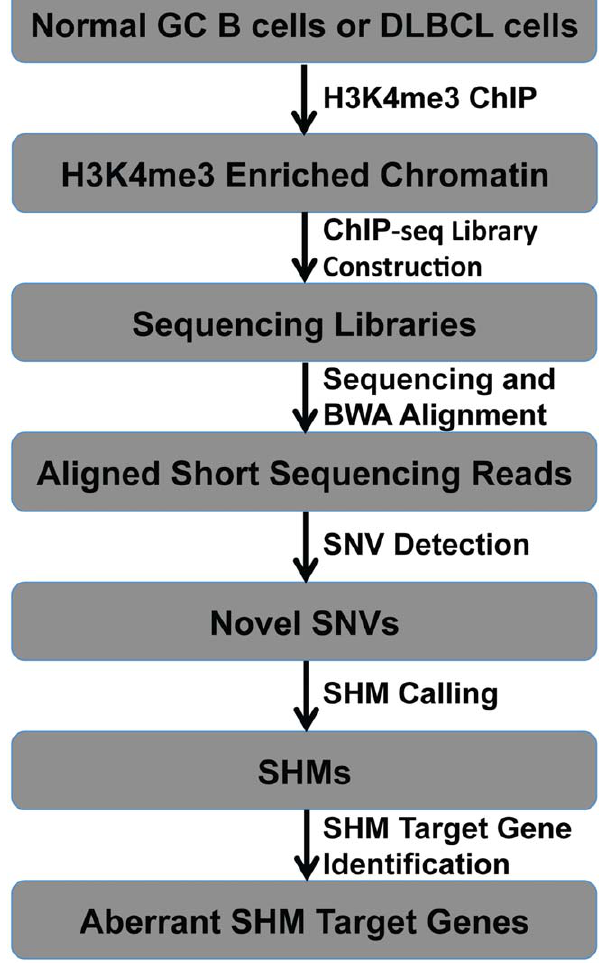
Figure 1. Approach to detect aberrant SHM target genes genome-wide.